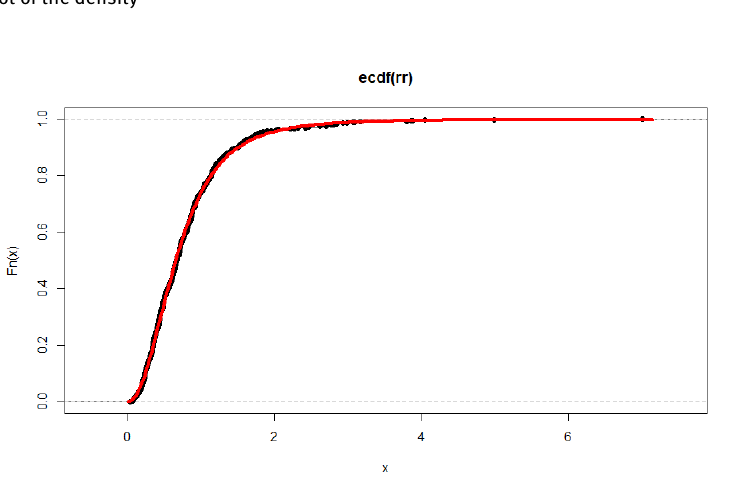
Figure 12: contour plot of the density